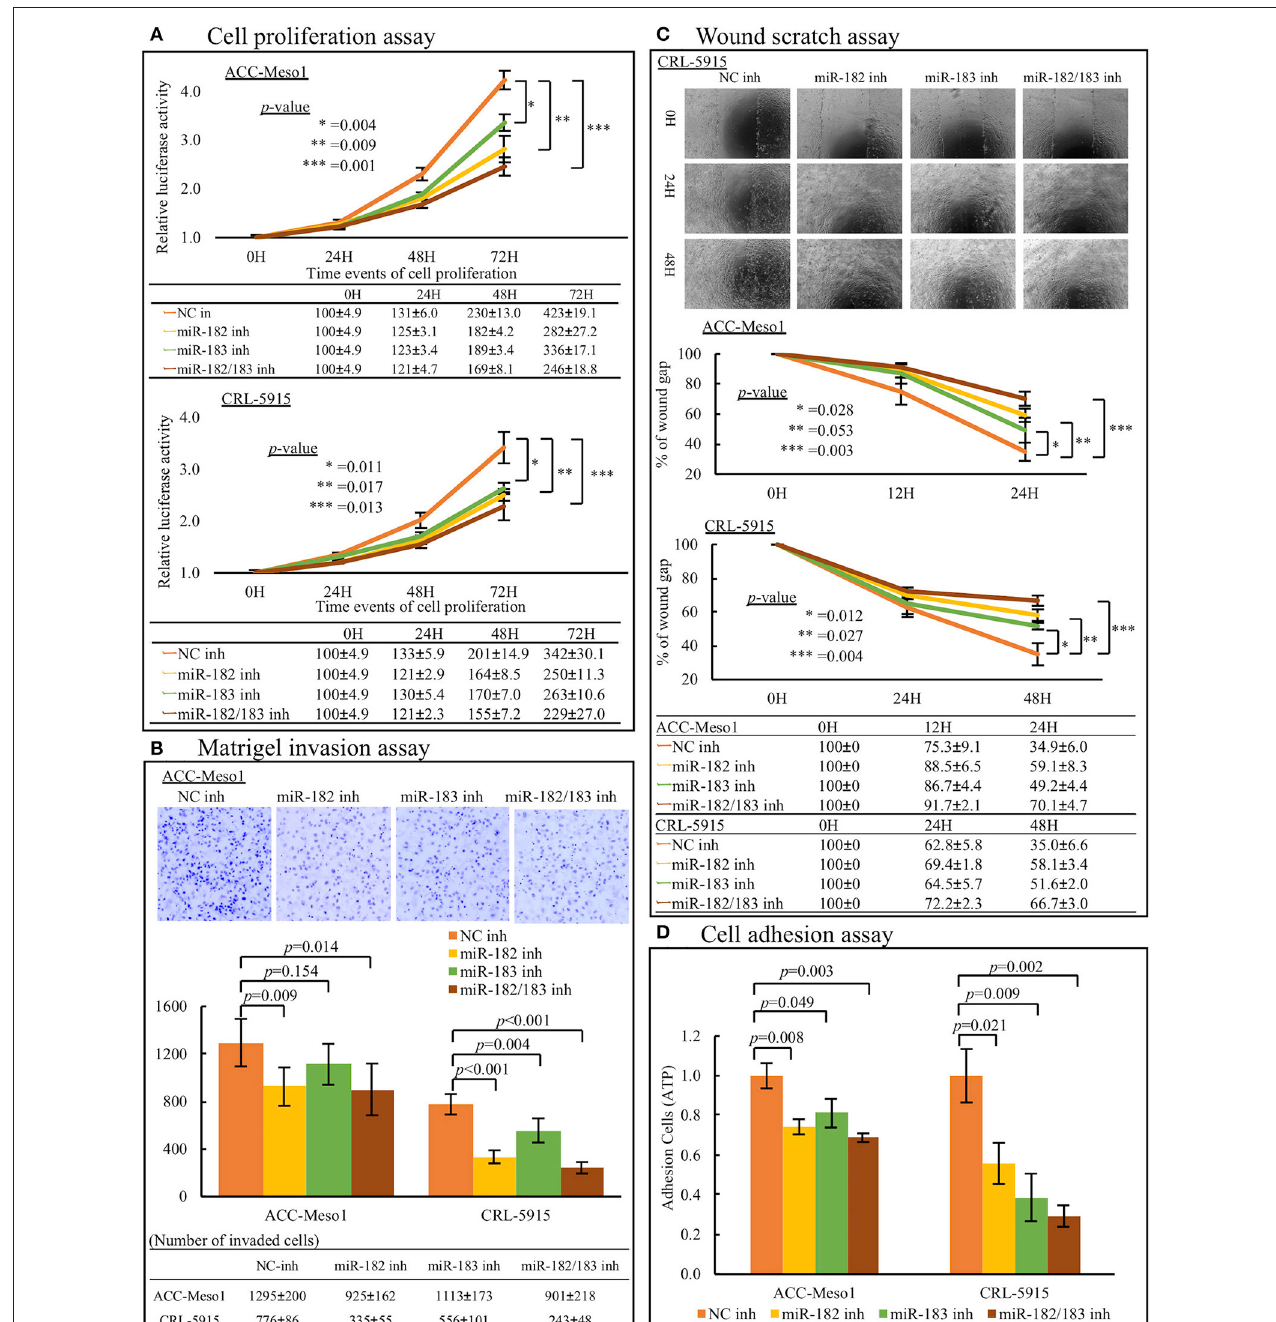
FIGURE 2 | (A) Cell proliferation analysis. Mesothelioma cell lines (ACC-MESO1 and CRL5915) transfected with miR-182, miR-183, and a combination of both inhibitors (miR-182 inh, miR-183 inh, miR-182/183 inh) for 1, 2, and 3 days showed increasingly reduced cell proliferation compared to cells treated with negative control miRNA inhibitor (NC inh). Data were acquired on a microplate reader using Cell Titer Glo reagent ( p < 0.05). (B) Invasion assay. Mesothelioma cell lines transfected with miR-182 inhibitor, miR-183 inhibitor, and a combination of both inhibitors for 24 (ACC-MESO1) or 48 (CRL-5915) h showed reduced invasiveness through the Matrigel compared to cells treated with negative control miRNA inhibitor ( p < 0.05 except between NC-inhibited and miR-183-inhibited ACC-MESO1 cells). Upper panel figures show representative inverted fluorescence images acquired using CellProfiler Image analysis software. (C) Migration assay. Mesothelioma cells (ACC-MESO1 and CRL-5915) transfected with miR-182 inhibitor, miR-183 inhibitor, and a combination of both inhibitors showed reduced migration abilities compared to cells transfected with negative control miRNA mimic ( p < 0.05 except between NC-inhibited and miR-183-inhibited ACC-MESO1 cells). Upper panel figures are representative images acquired using an inverted phase contrast microscope. (D) Cell Adhesion assay. Mesothelioma cells (ACC-MESO1 and CRL-5915) transfected with miR-182 inhibitor, miR-183 inhibitor, and a combination of both inhibitors showed reduced adhesion compared to cells transfected with negative control miRNA inhibitor ( p <